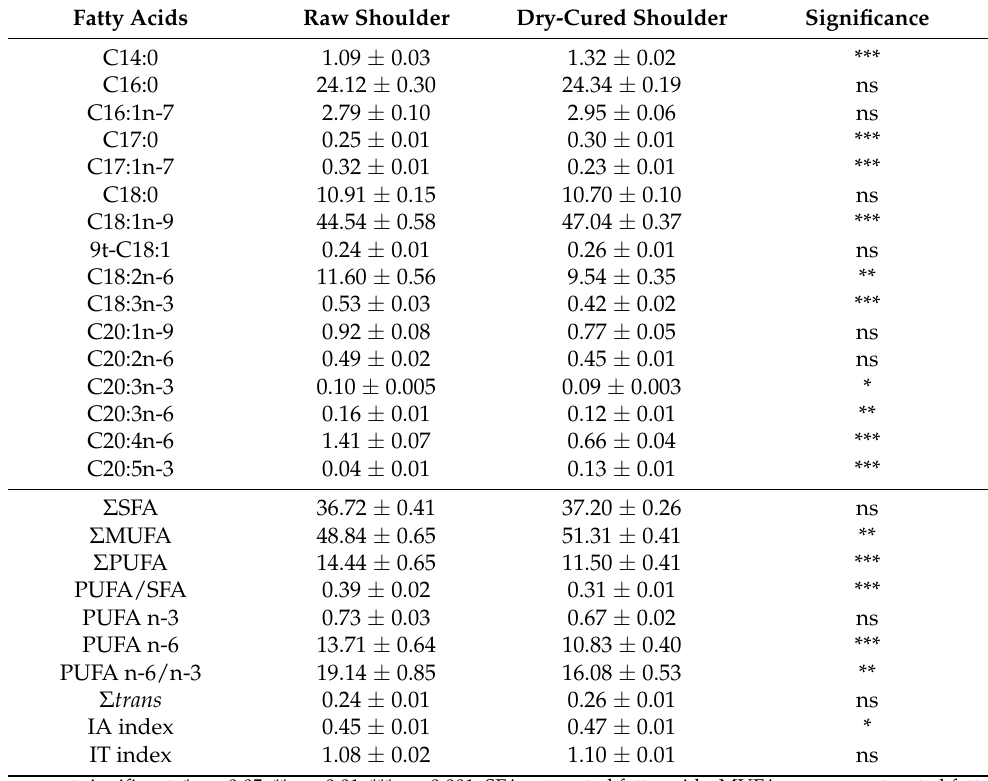
Table 2. Fatty acids profile (mean ± standard error) of raw and dry-cured B í saro shoulder. Fatty Acids Raw Shoulder Dry-Cured Shoulder Significance C14:0 1.09 ±